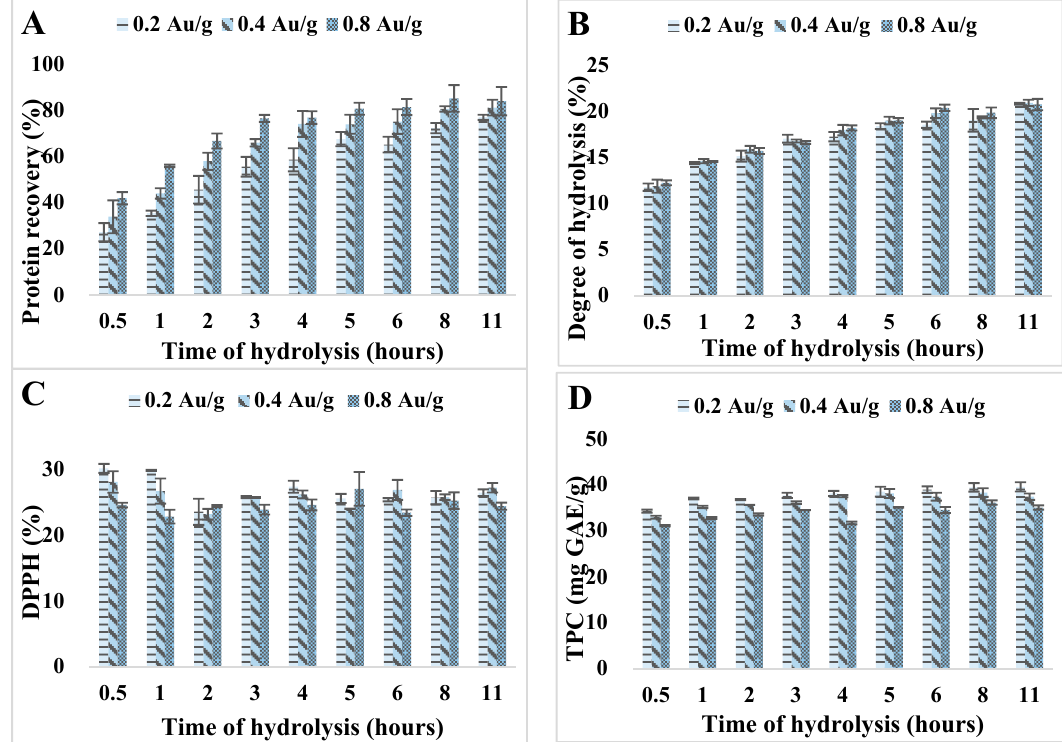
Figure 1. Reaction optimization of antioxidant kafirin Alcalase hydrolysates prepared at combined hydrolysis time of 0.5 to 11 h and enzyme-to-substrate ratios of 0.2, 0.4, and 0.8 Au / g. ( A ). Total protein recovery (%); ( B ). degree of hydrolysis; ( C ). DPPH scavenging activity (%) at 5 mg / mL; ( D ). total phenolic content (mg GAE /